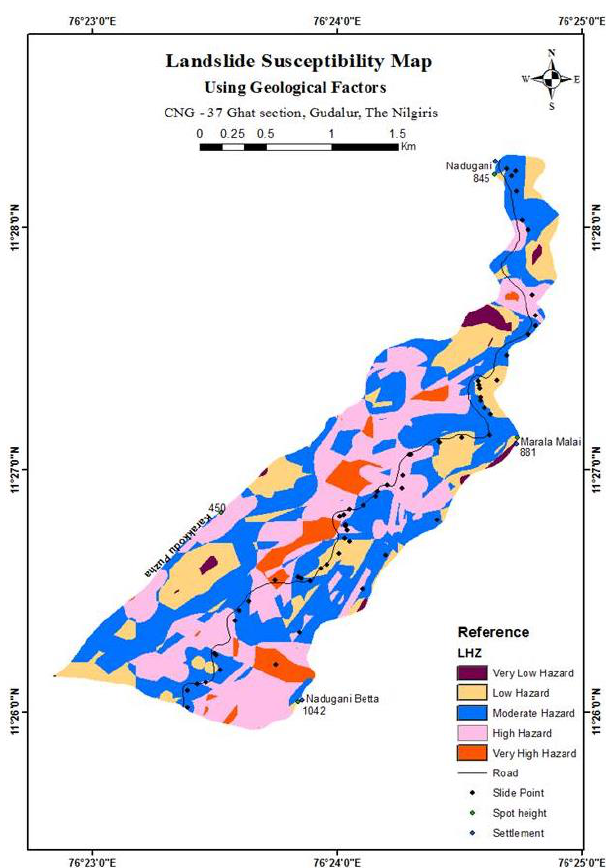
Figure 6 LSZ map using geological